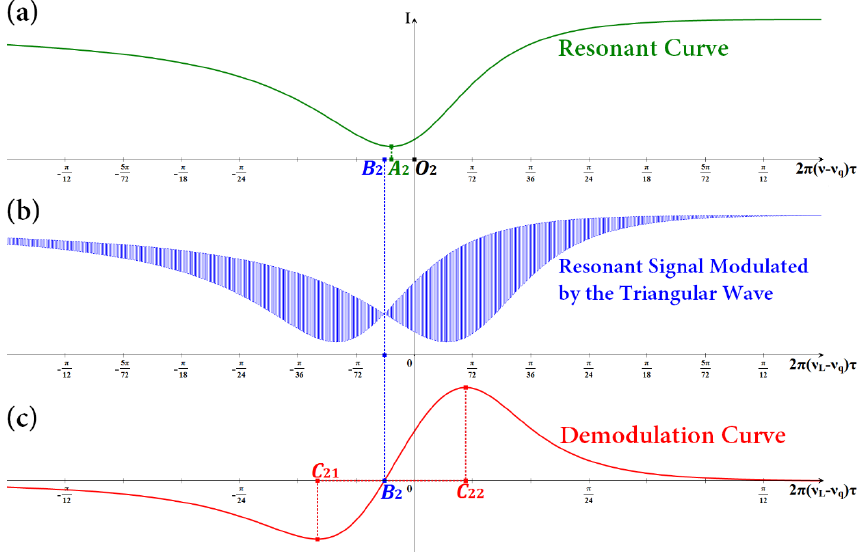
Figure 5. When φ 0 = 0.9 π , ( a ) simulated resonant curve, ( b ) simulated resonant signal modulated by the triangular wave, and ( c ) simulated demodulation curve can be obtained.